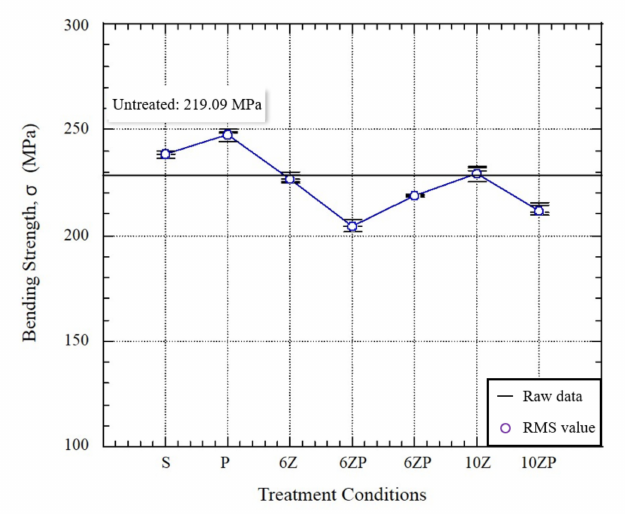
Figure 8. Bending strength of 6-layer aramid fabric under various